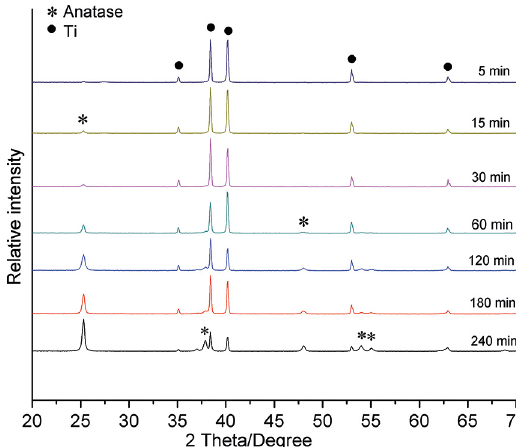
samples annealed at 450 °C during 2